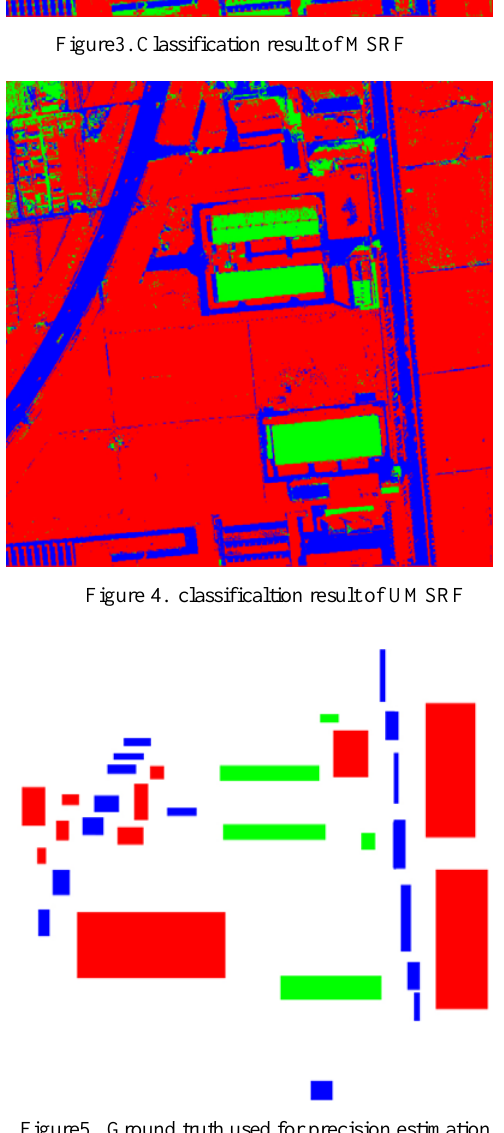
Figure5. Ground truth used for precision